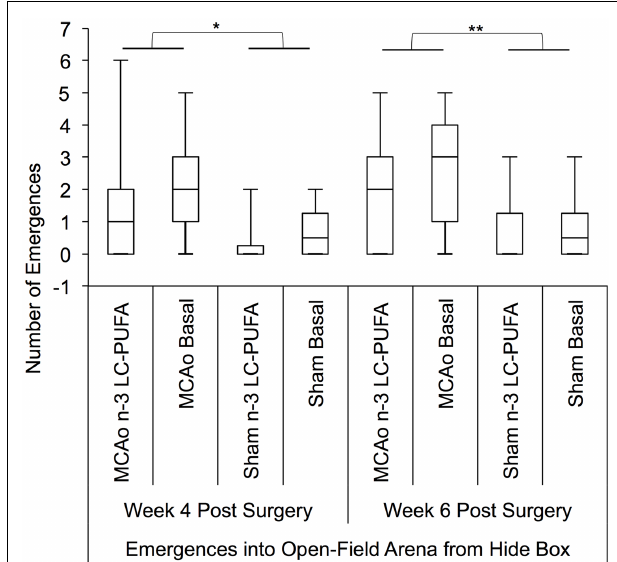
FIGURE 7 | Box plots showing significant post hoc differences in emergence duration between diet and surgery conditions at 6weeks post-surgery .Visual inspection of this Figure indicates that sham surgery-operated animals spent less time moving around in the open-field arena compared to MCAo operated animals. Furthermore, in each surgery condition, n -3-LC-PUFA diet fed animals spent less time moving around the open-field arena than do basal diet fed animals. MCAo, middle cerebral artery occlusion surgery condition; Sham, Sham surgery condition; Basal, basal diet fed rats; n -3-LC-PUFA, polyunsaturated fatty acid supplemented rats. n = 11 n -3-LC-PUFA MCAo; n = 13 Basal MCAo; n = 12 n -3-LC-PUFA sham; n = 12 Basal